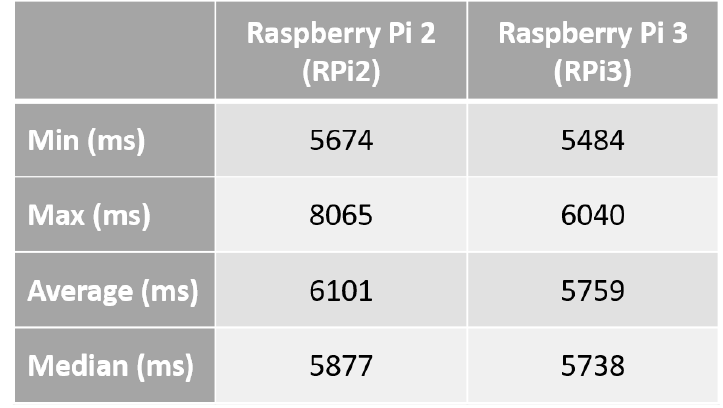
Figure 18. Statistical results of the complete mode tests in RPi2 and